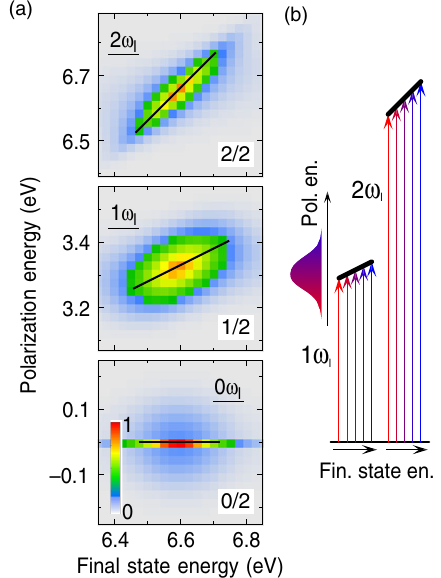
FIG. 4. (a) Expanded components of the OBE calculated 2D- FT spectra corresponding to the SS state signal from Fig. 3(b). The color table of each polarization order ( 0 ω l , 1 ω l , 2 ω l ) is scaled separately. The 2D spectra for the zero-order component ( 0 ω l ) is horizontal; the 2D spectra at the driving laser frequency ( 1 ω l ) and its second harmonic ( 2 ω l ) disperse (tilt) with the final state energy; the slopes for a coherent process are indicated by black lines and quantified by the ratios in the white boxes. (b) Schematic illustration of how the induced polarizations produce the dispersive FT amplitudes in the 2D spectra: Each frequency component within the spectral range of the laser pulse terminates at a specific final state energy; left: linear polarizations ( 1 ω l ), right: second-order polarizations ( 2 ω l